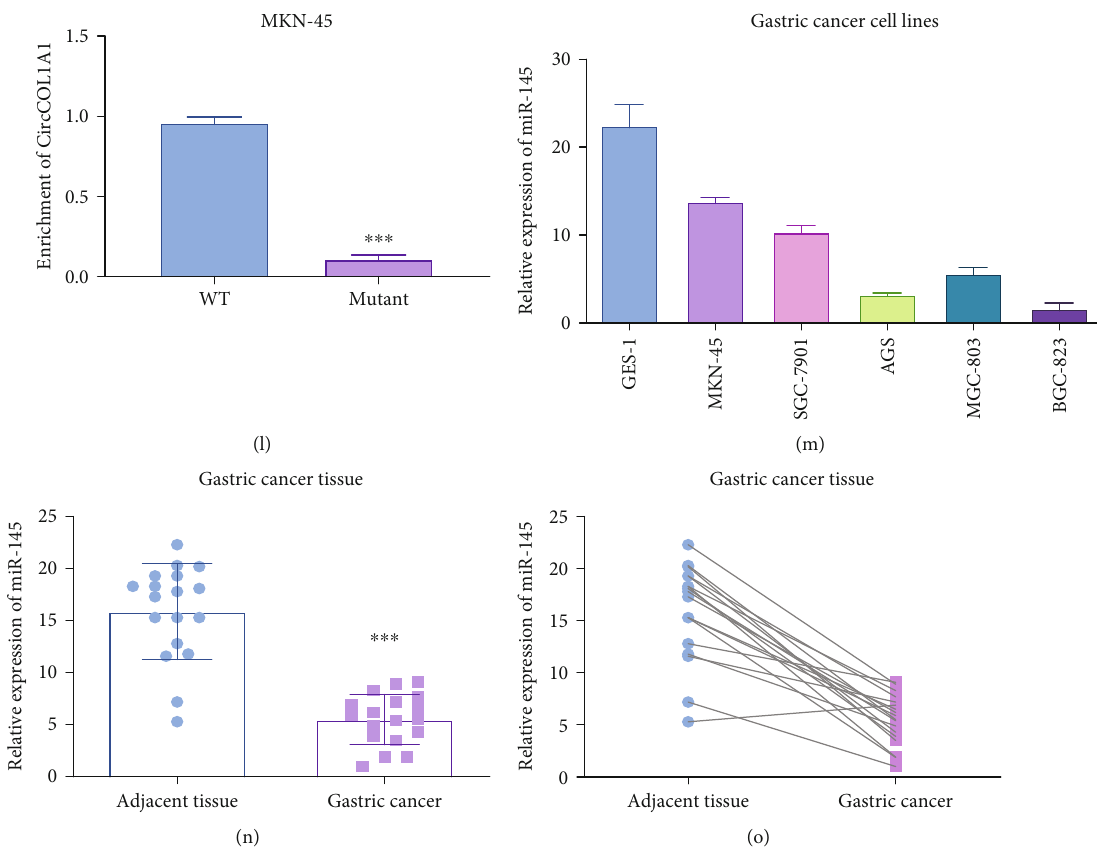
Figure 4: circCOL1A1 targets miR-145 by acting as a microRNA sponge. (a) Putative binding site between circCOL1A1 and miR-145 is shown. (b, c) circCOL1A1 was silenced in AGS and BGS-823 cells and reexpressed circCOL1A1 in AGS and BGS-823. qRT-PCR was performed. (d, e) circCOL1A1 was overexpressed in MKN-45 and SGC-7901 cells and then silenced circCOL1A1 in circCOL1A1 overexpressing cells. qRT-PCR was performed. (f, g) circCOL1A1 was silenced in AGS and BGS-823 cells and reexpressed circCOL1A1 in AGS and BGS-823. Luciferase reporter assays were performed. (h, i) circCOL1A1 was overexpressed in MKN-45 and SGC-7901 cells and then silenced circCOL1A1 in circCOL1A1 overexpressing cells. Luciferase reporter assays were performed. (j) The wild type and mutation of miR-145 were indicated. (k, l) RNA pull-down assays were performed to validate the direct interaction between miR-145 and circCOL1A1. (m) The expression level of miR-145 in gastric cancer cell lines by qRT-PCR. (n, o) The expression level of miR-145 in gastric cancer tissues by